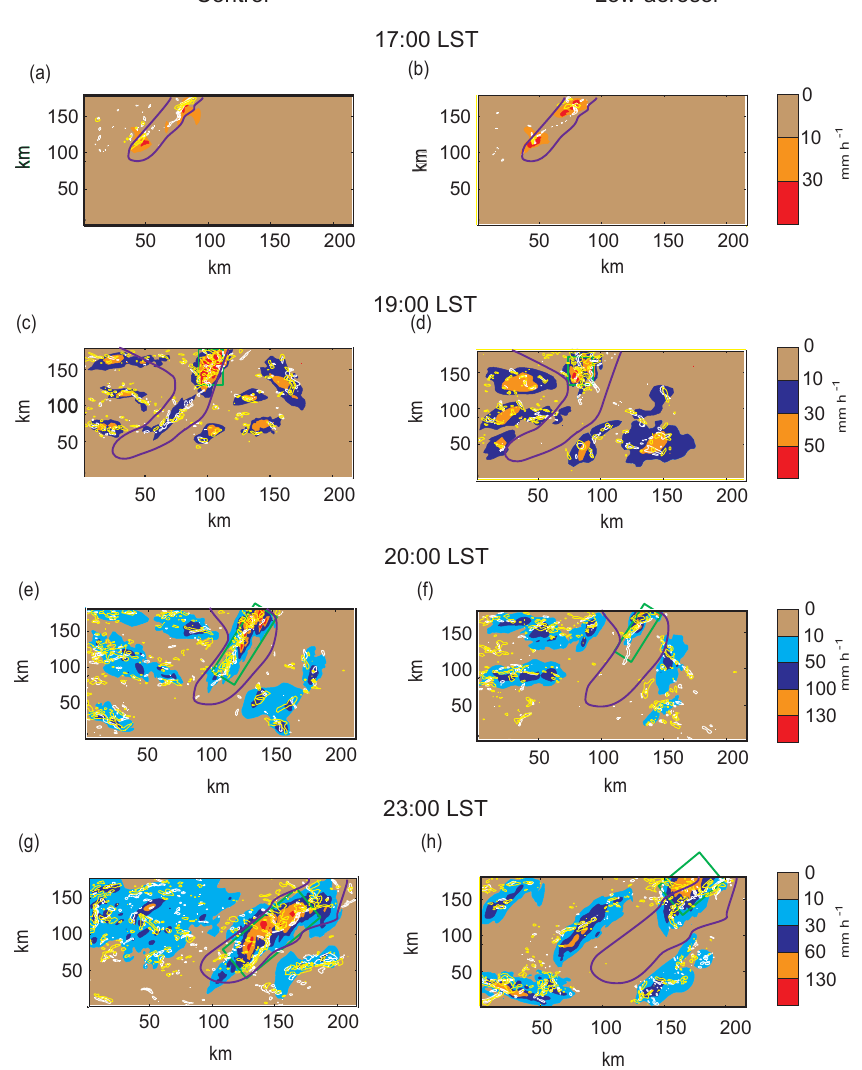
Figure 10. Same as Fig. 8 but with convergence at the surface (white contours) and the column-averaged condensation rates (yellow contours) which are superimposed on the precipitation field. In panels (a) and (b) , white contours are at 0.4 and 0 . 7 × 10 − 2 s − 1 and yellow contours are at 0.4 and 0.9gm − 3 h − 1 . In panels (c) and (d) , white contours are at 0.9 and 1 . 7 × 10 − 2 s − 1 and yellow contours are at 0.9 and 1.5gm − 3 h − 1 . In panels (e) and (f) , white contours are at 1.4 and 2 . 3 × 10 − 2 s − 1 and yellow contours are at 1.3 and 2.9gm − 3 h − 1 . In panels (g) and (h) , white contours are at 2.1 and 3 . 5 × 10 − 2 s − 1 and yellow contours are at 2.3 and 3.8gm − 3 h − 1